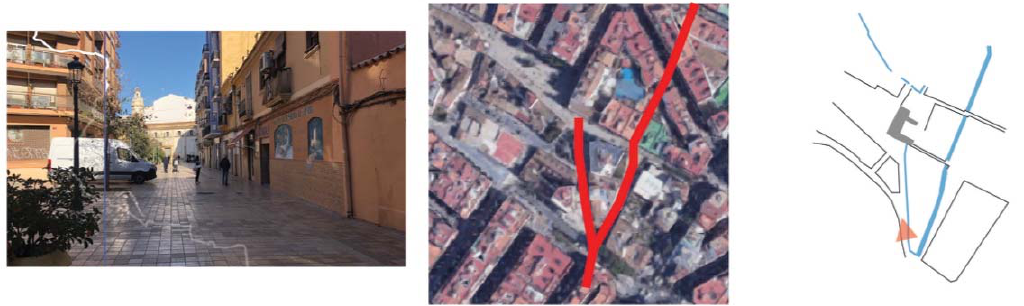
Figure 19. The image of a building block inherited the canal line, the satellite image and the diagram of spatial structure created based on the cadaster created between 1929 and 1946 at the same location.